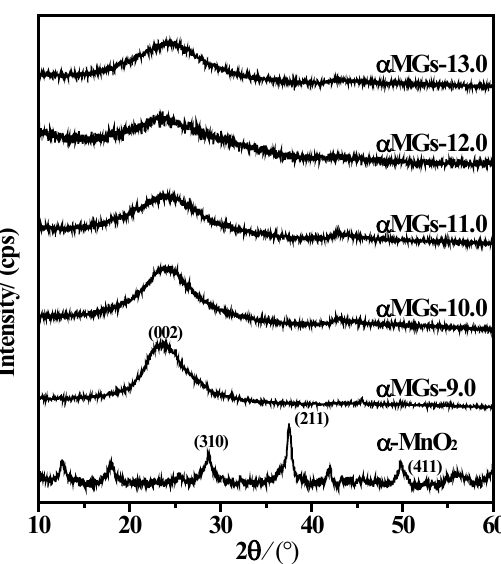
Figure 5. XRD patterns of αMGs -X samples at different hydrothermal pH levels.